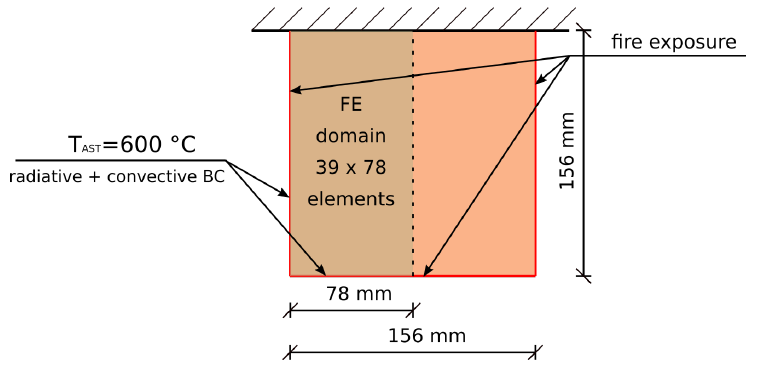
Figure 12. Geometry of the 2D